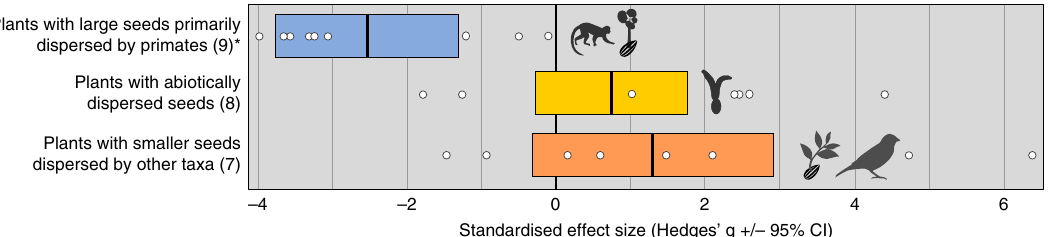
Fig. 4 Effect sizes of defaunation on forest regeneration by seed dispersal syndrome. All studies were observed. The number of pairwise comparisons between high fauna and low fauna treatments per category is reported in parentheses, mean standardised effect size (Hedges ’ g ) is indicated by the bold vertical line in the centre of the coloured box, and 95% con fi dence intervals are represented by the width of the coloured box. Asterisks (*) denote categories where the con fi dence intervals do not overlap zero, indicating a signi fi cant effect (Hedges ’ g ). Please note that the fi gure shows the impact of defaunation on the regeneration of woody plants with different dispersal syndromes; a negative effect size means that defaunation is having a